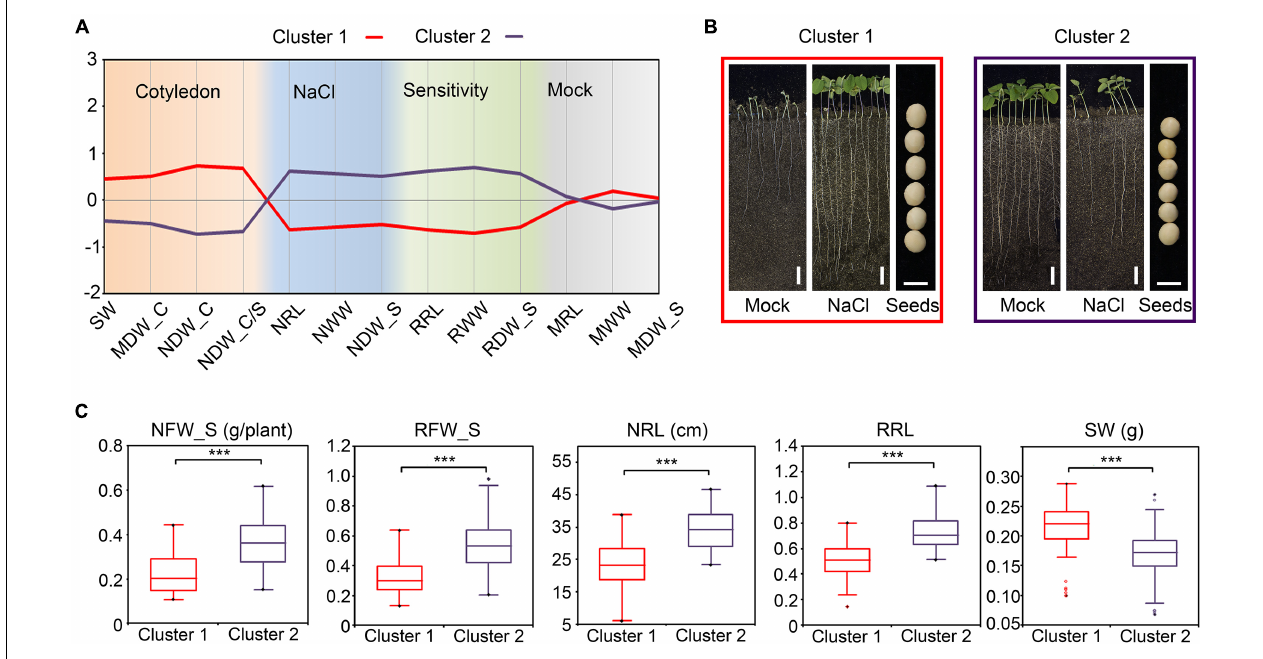
FIGURE 7 | Agglomerative hierarchical clustering of salt stress-related traits in soybean (A) The profile plot of the agglomerative hierarchical clustering of salt stress-related traits in soybean. Analysis was performed with the standardized indices. (B) Phenotypes of the representative cultivar for Cluster 1 and Cluster 2. Images of the whole seedlings from the soybean cultivars grown in WinRoots for 10 days. Bar, 5 cm in the whole-seedling images. Bar, 5 mm in the seeds images. (C) The comparison between the indices of Cluster 1 and Cluster 2. *** P < 0.0001 ( n = 146), un-paired Student’s t